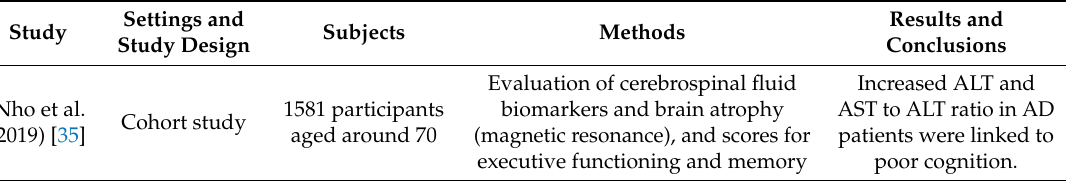
Results and Conclusions Increased ALT and AST to ALT ratio in AD patients were linked to poor